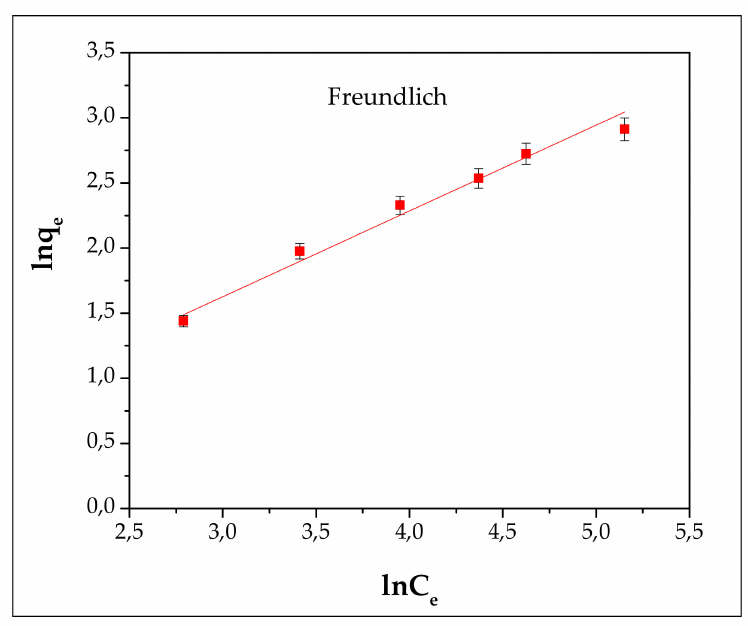
Figure 8. Langmuir isotherm plot of Cd 2 + adsorption on FA / H 2 SO 4 .